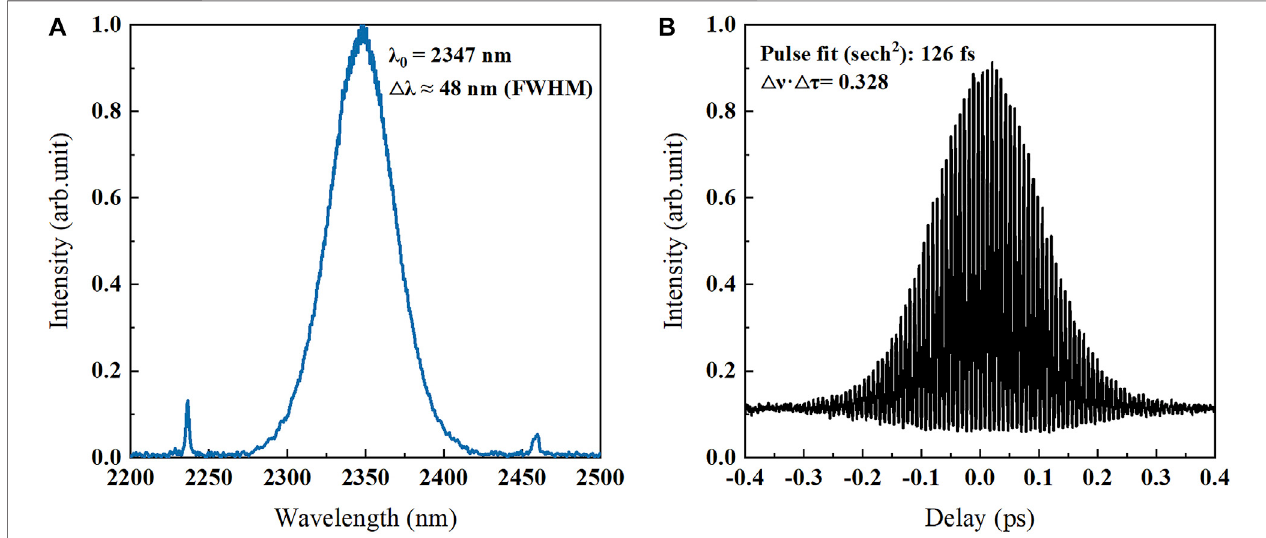
FIGURE 4 | Measured spectrum and autocorrelation trace at 2,347 nm center wavelength. (A) Optical spectrum. (B) Interferometric autocorrelation trace.